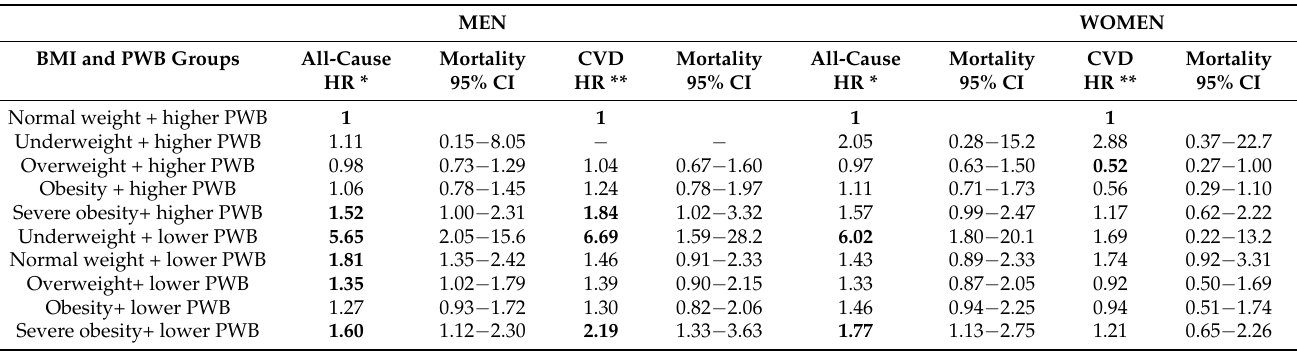
Table 4. The influence of combined status of body mass index and psychological well-being for the estimation of all-cause mortality risk and CVD mortality risk (follow-up for endpoints period mean (SD) 12.6 (2.79)